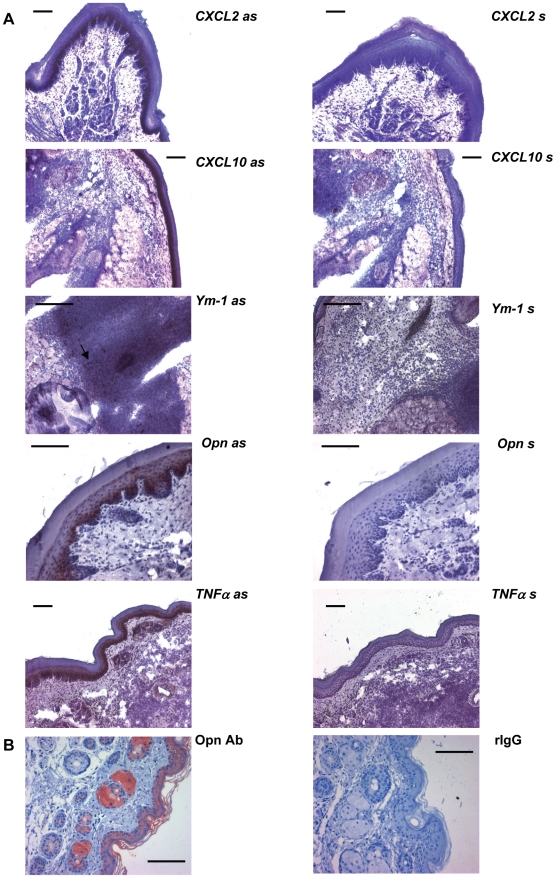

In-situ-hybridization and immunohistochemistry.The cellular expression pattern of the indicated genes was analyzed in footpads of C57BL/6 mice infected 16 h with L. major by in-situ-hybridization (A) and immunohistochemistry (B). The arrow indicates Ym-1 positive cells in the infiltrate. Bars represent 50 µm; as = antisense RNA probe; s = sense RNA probe; Opn Ab = rat anti mouse monoclonal antibody against opn; rIgG = rat IgG.